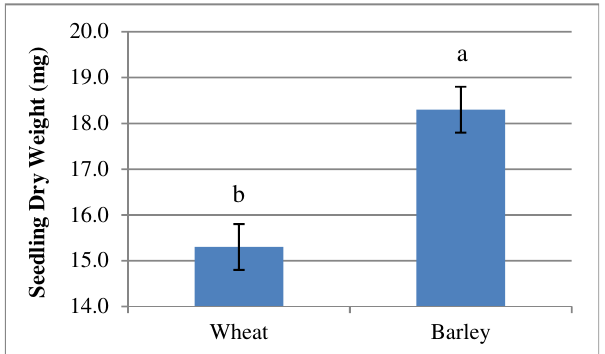
Fig. 3. Effect of plant species on seedling dry weight. Means by the uncommon letter are significantly different according to Duncan tests (p < Mean square F.W. D.W.